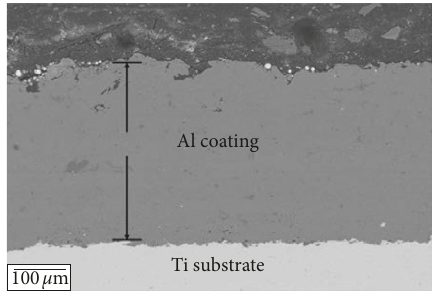
Figure 1: Cross-sectional BSD image of Al coating without